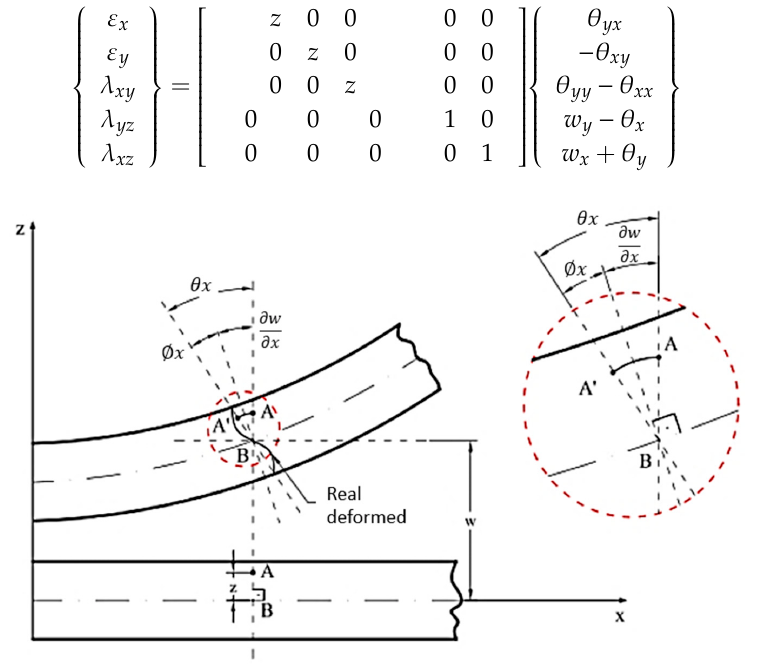
Figure 20. Field of displacements according to Reissner–Mindlin plate theory Reproduced with permission [212] .